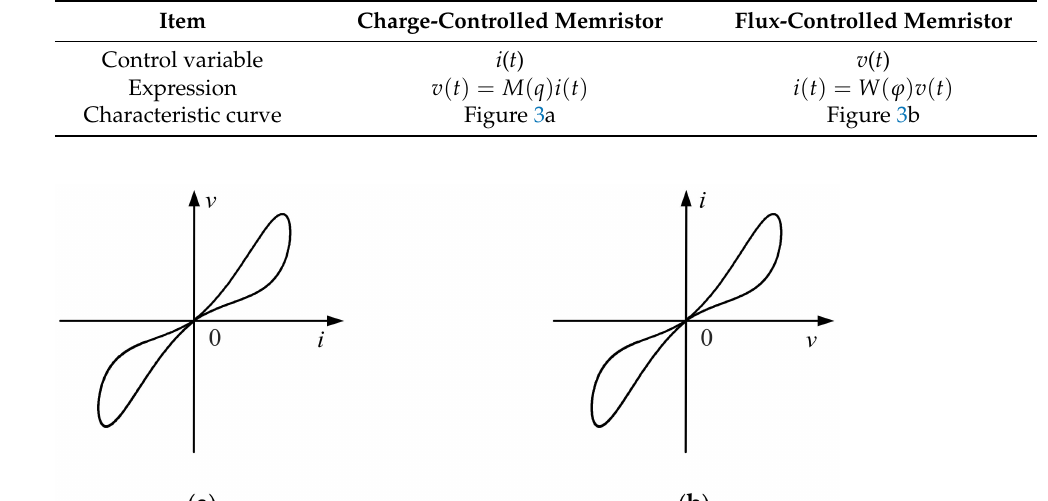
Table 2. Characteristics of the memristor.